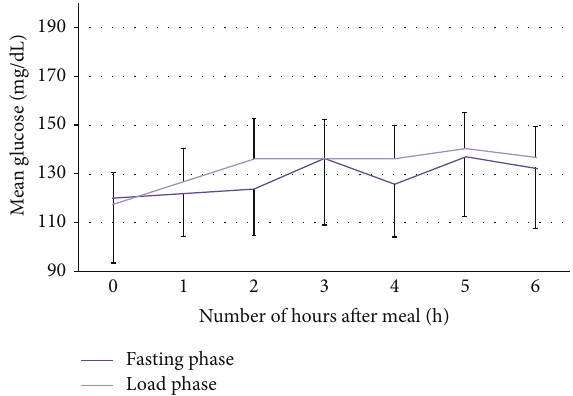
Figure 1: Glucose patterns in the study subjects during fasting state and after protein load, for the same rate of basal insulin dose. Data are presented as mean glucose and standard